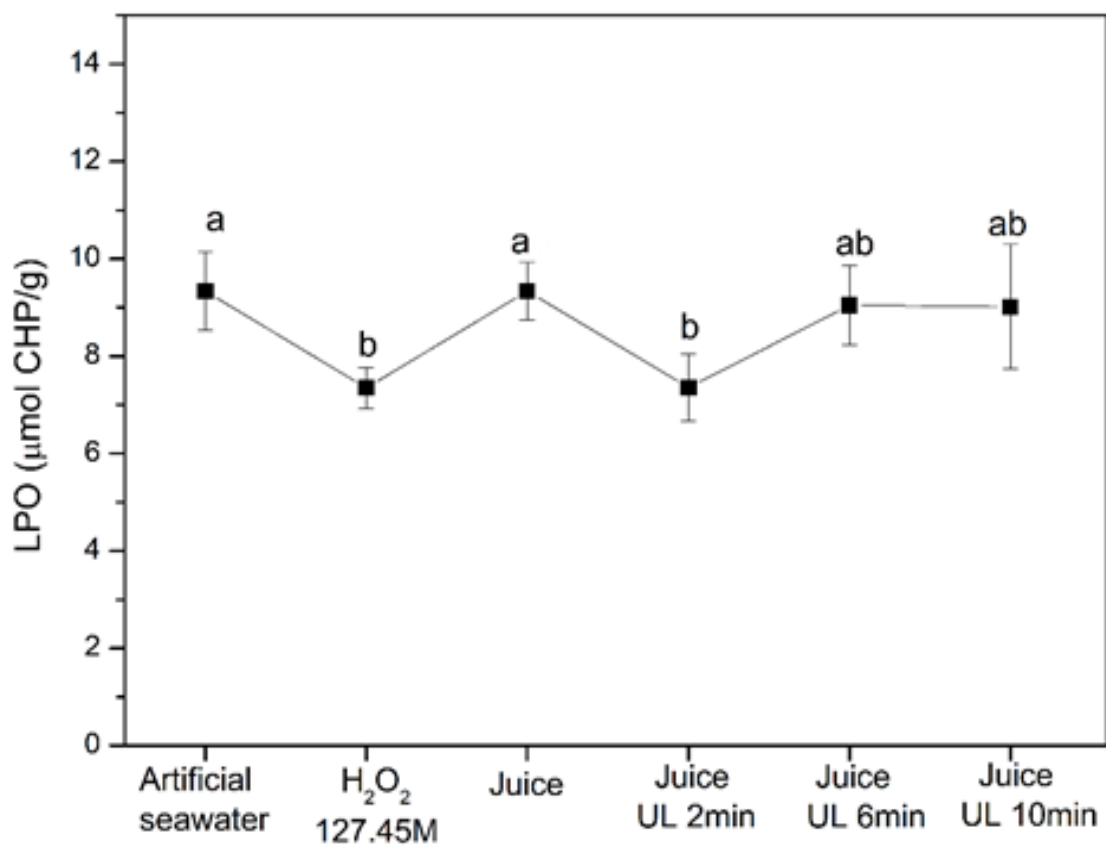
Figure 11. Lipid peroxidation (LPO) of unprocessed sapota-do-Solimões juice and processed by ultrasound (1000 μg·mL −1 ) on Artemia salina nauplii after 72 h of H 2 O 2 exposure. The different letters indicate statistically significant differences ( p ≤ 0.05).